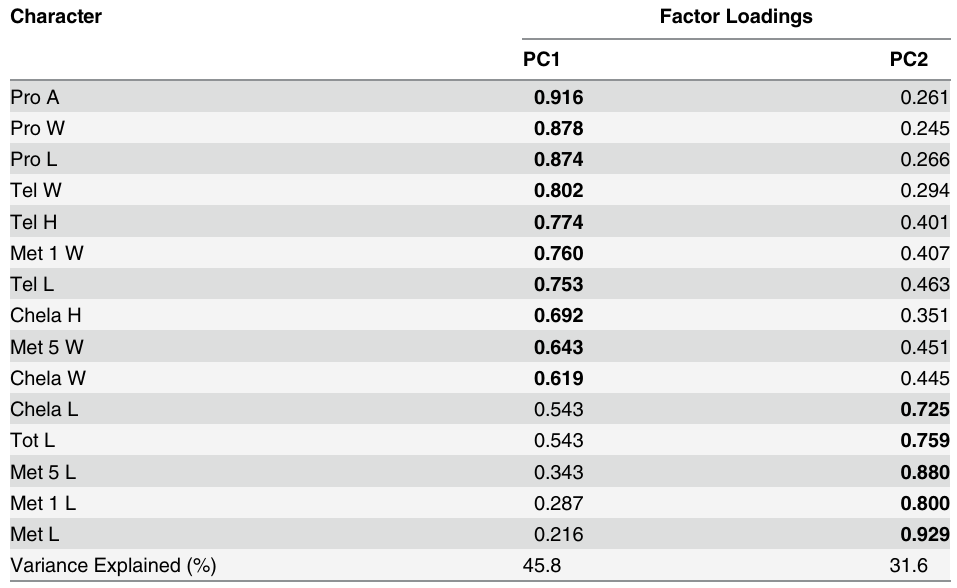
Table 3. Factor loadings for the two principal components (PC1, PC2) extracted from the principal component analysis of Hadrurus arizonensis morphological